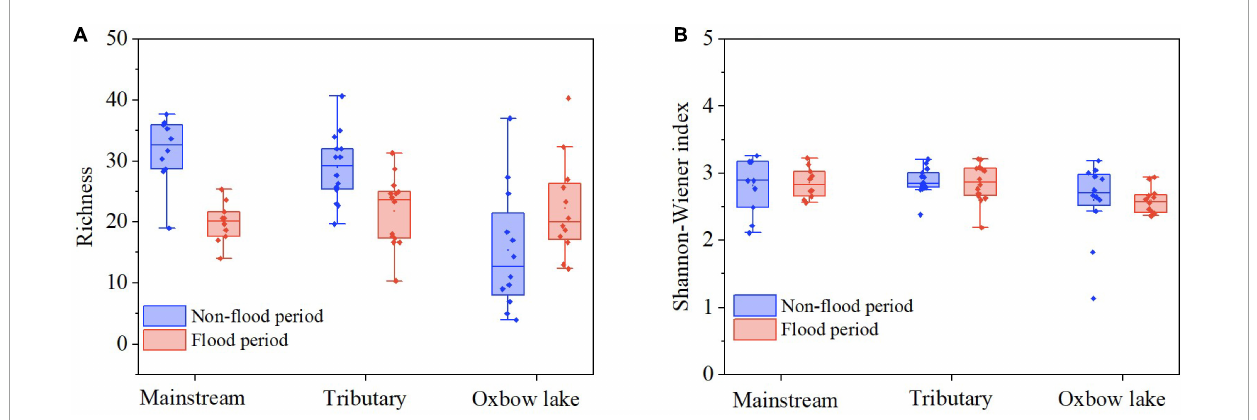
geographical distance had significant influence on mainstream